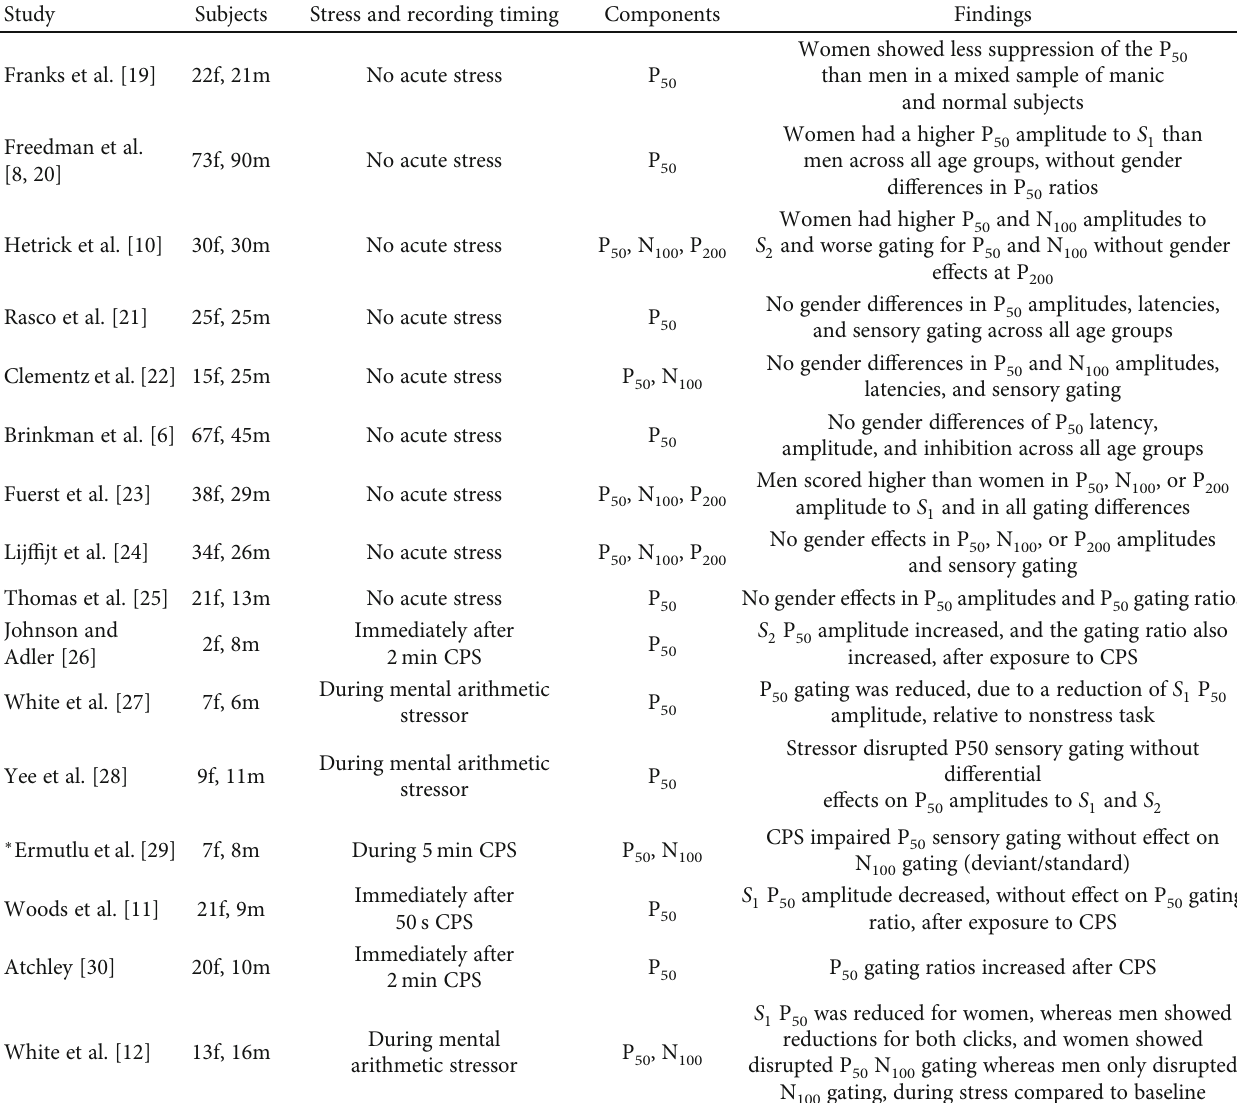
Table 1: Summary of studies investigating auditory sensory gating concerning gender di ff erence and acute stress e ff